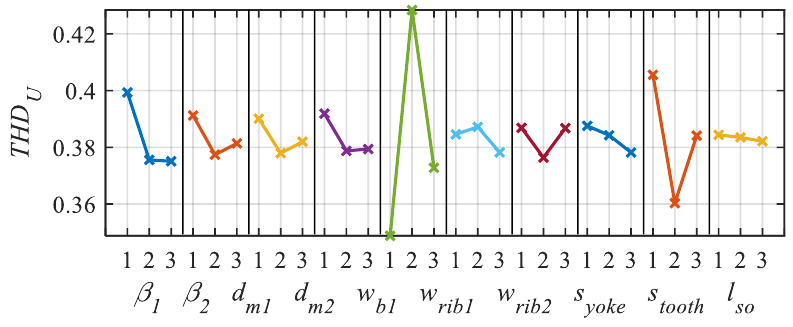
Figure 13. Plot of main factor effects on THD of phase voltage ( THD U ).